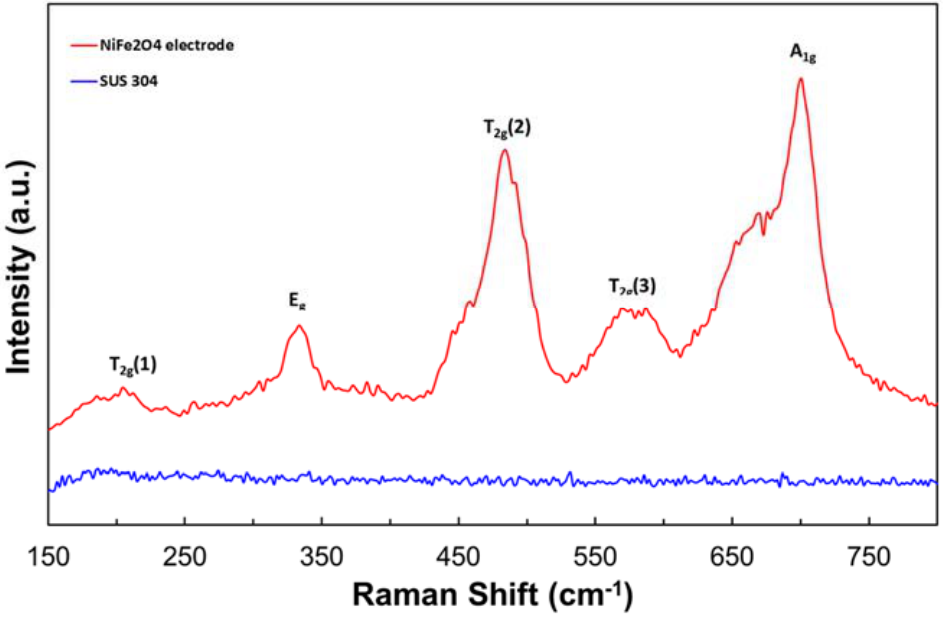
Figure 5. Raman spectra of NFO-800 and stainless steel.